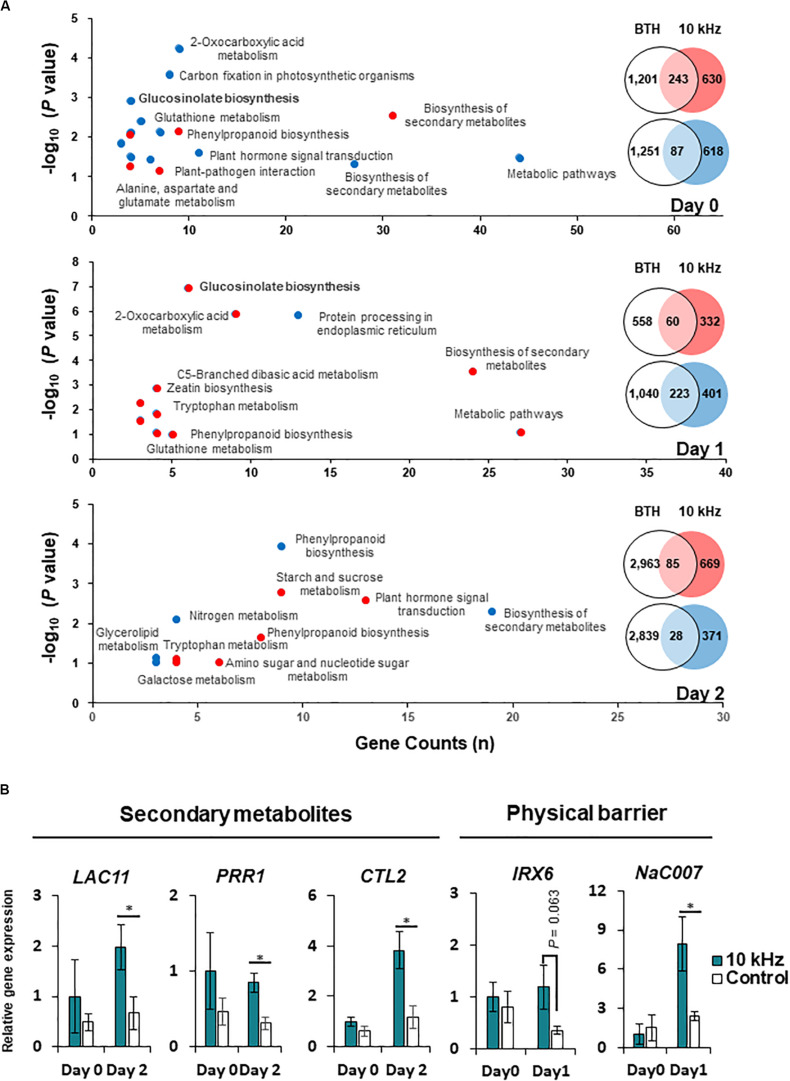
Modification of gene expression in SV (10 kHz)-treated Arabidopsis plants compared with BTH-treated plants. (A) Venn diagram and major functions of differentially expressed genes (DEGs) in 10 kHz-treated plants compared with BTH-treated plants at 0, 1, and 2 days post-inoculation (dpi) with R. solanacearum. Up-regulated genes are indicated in red, and down-regulated genes are indicated in blue. (B) Quantitative PCR (qPCR)-based validation of RNA-seq data. The expression of genes related to biosynthesis of secondary metabolites and physical barrier were examined by qPCR. (n = 3–4; *p < 0.05).